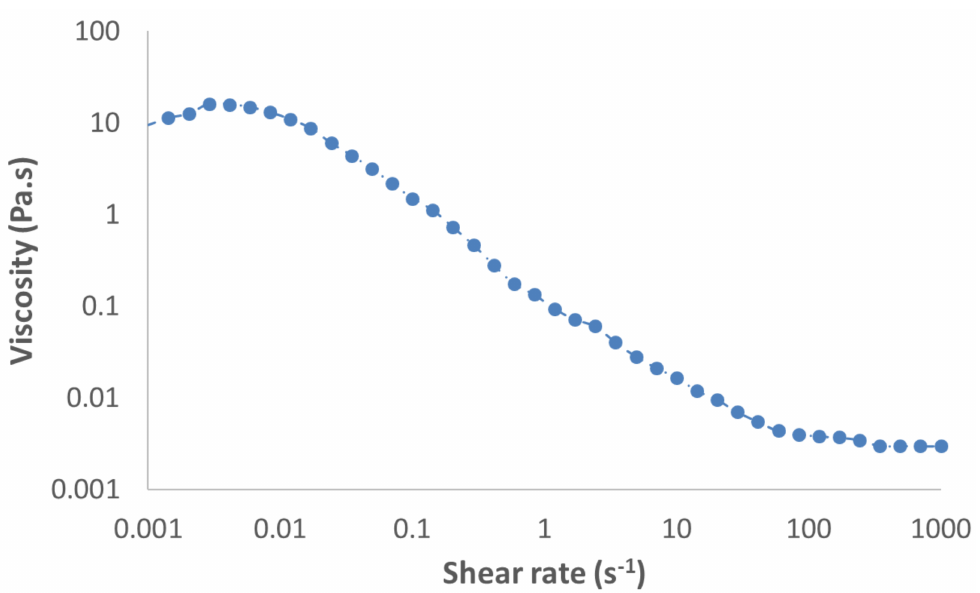
Figure 2. Viscosity of a solution of 0.1% ( w / w ) PAAm (polyacrylamide) in water, according to the shear